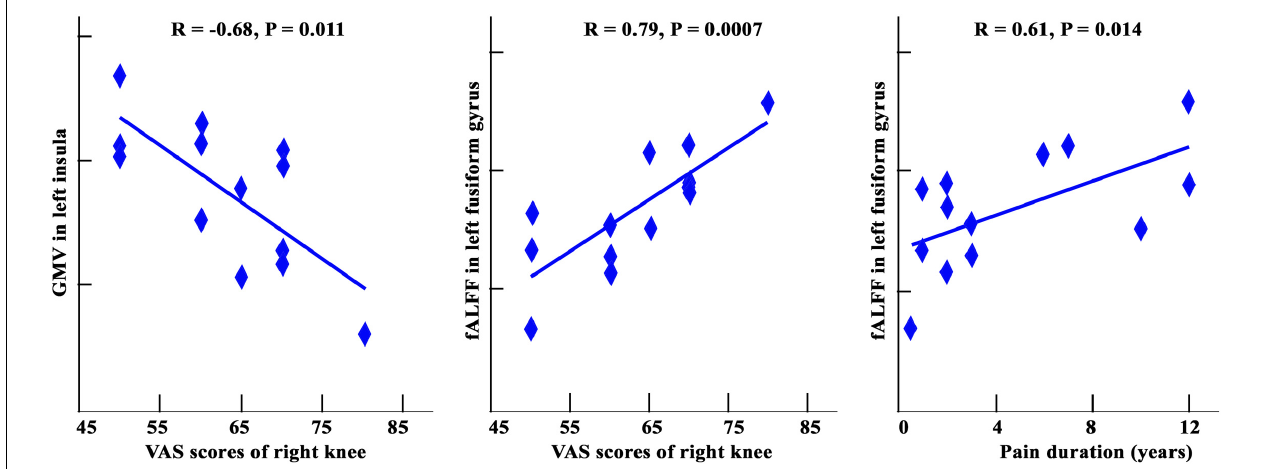
FIGURE 4 | A: Correlation analysis among GMV, fALFF, and clinical assessments in patients with KOA. Significantly negative correlation between GMV of left insula and VAS scores of right knees was found. The significantly positive correlations between fALFF values in left fusiform gyrus and VAS score and pain duration were also